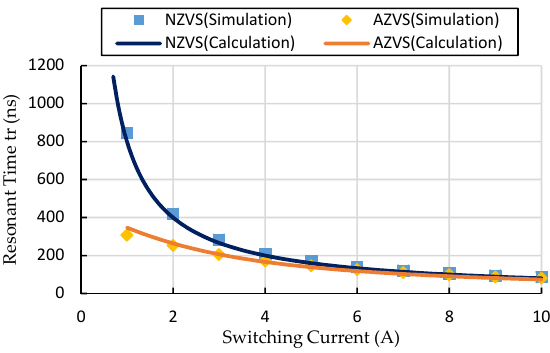
Figure 11. Resonant time vs. the switching current both in the calculation and simulation.